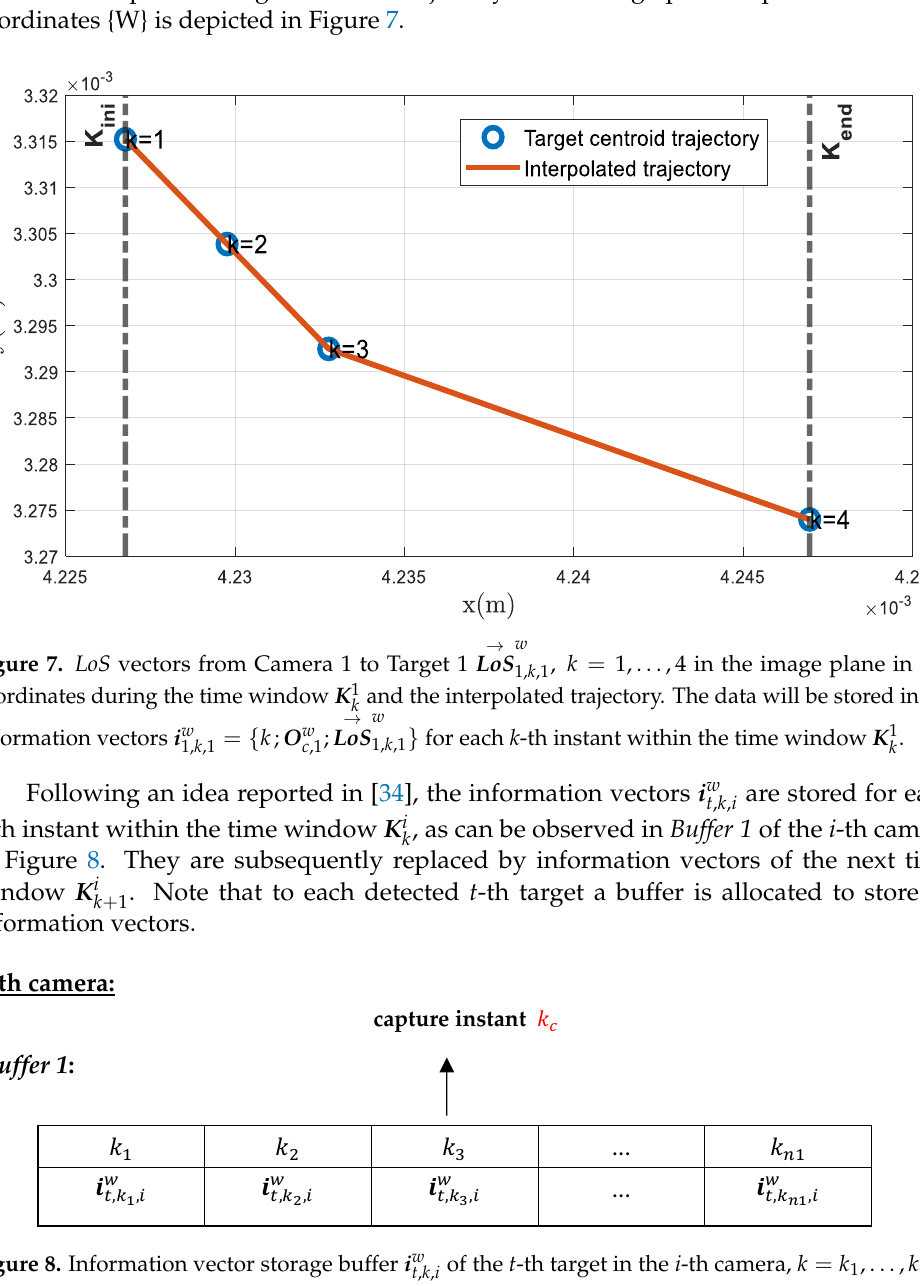
Figure 6. Top and front views of a detected target centroid trajectory within a time window 𝑲 (cid:3038)(cid:3036) . An example of a target centroid trajectory in the image plane expressed in world coordinates {W} is depicted in Figure 7.